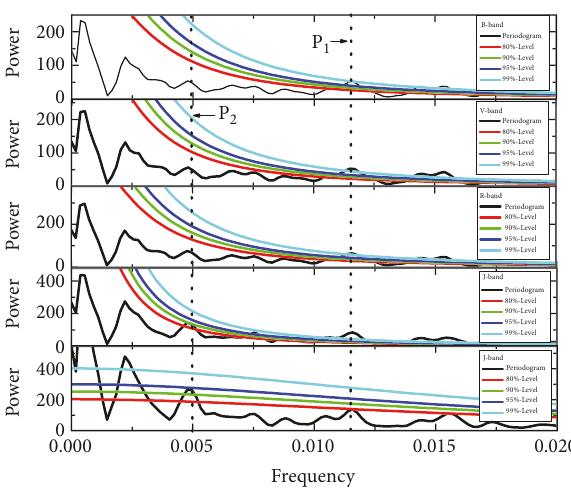
Figure 2: Using the Periodogram method to analyze the long-term BVRJK lightcurve.The frequency is in unit of 2𝜋 × 𝑑𝑎𝑦 −1 . The black line stands for periodic signal. The red line, green line, blue line, and cyan line stand for 80%, 90%, 95%, and 99% red-noise levels,